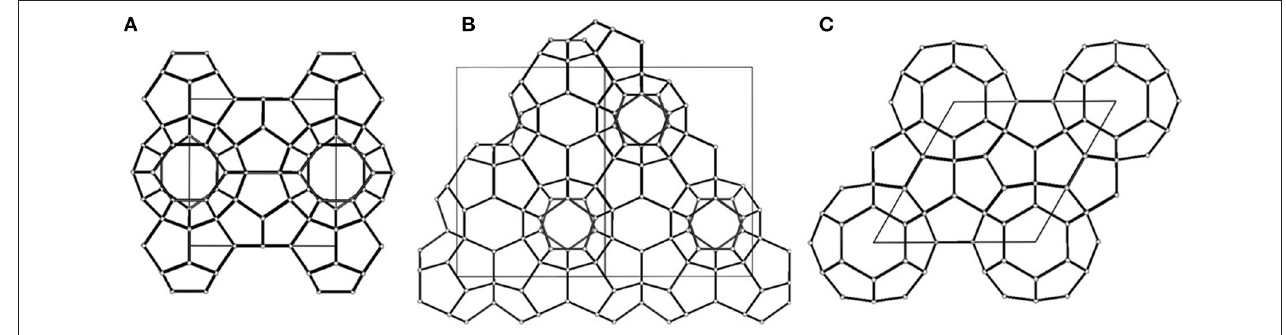
FIGURE 1 | Crystal structure types of gas hydrates: (A) Structure I, (B) Structure II, (C) Structure H; the solid line in each figure represents the unit cell of gas hydrates; reproduced from Takeya et al. (2009) with permission from the American Chemical